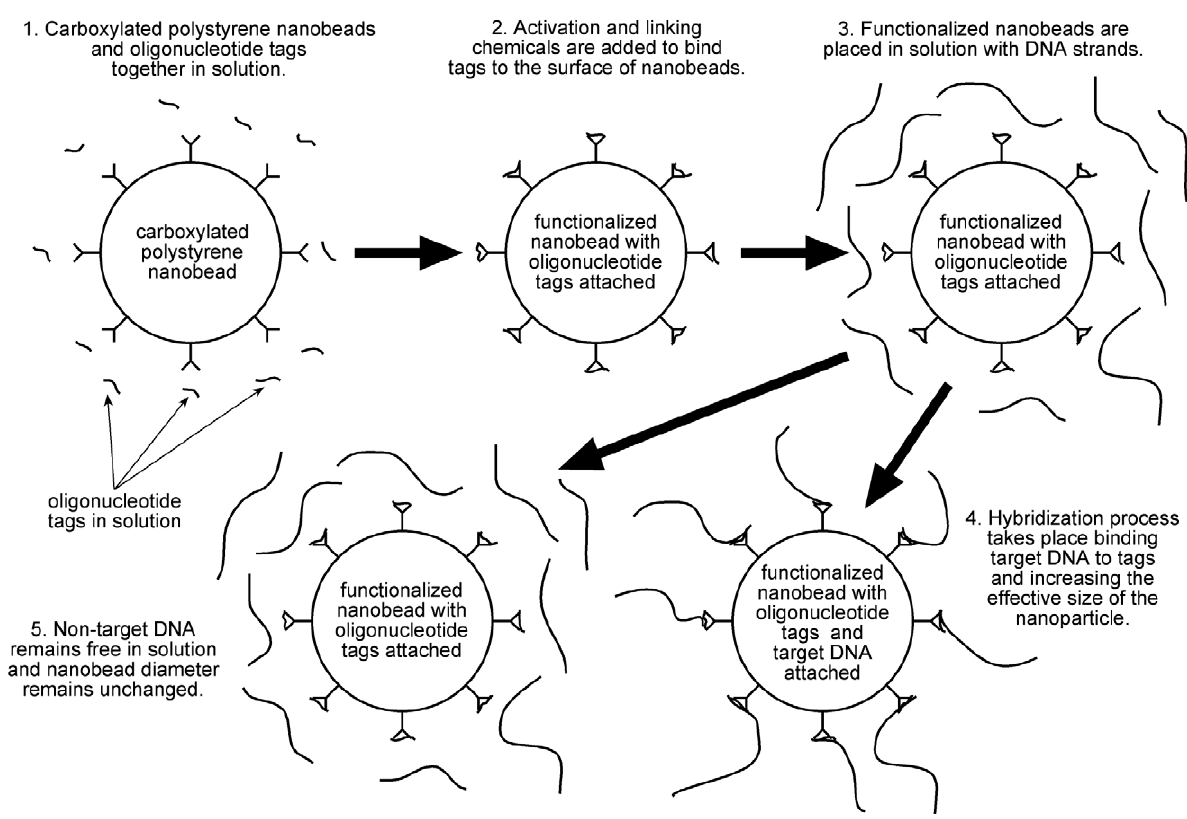
Figure 3. Schematic diagram of nanobead preparation (Steps 1 and 2) and binding of DNA to the functionalized beads (Steps 3–5).